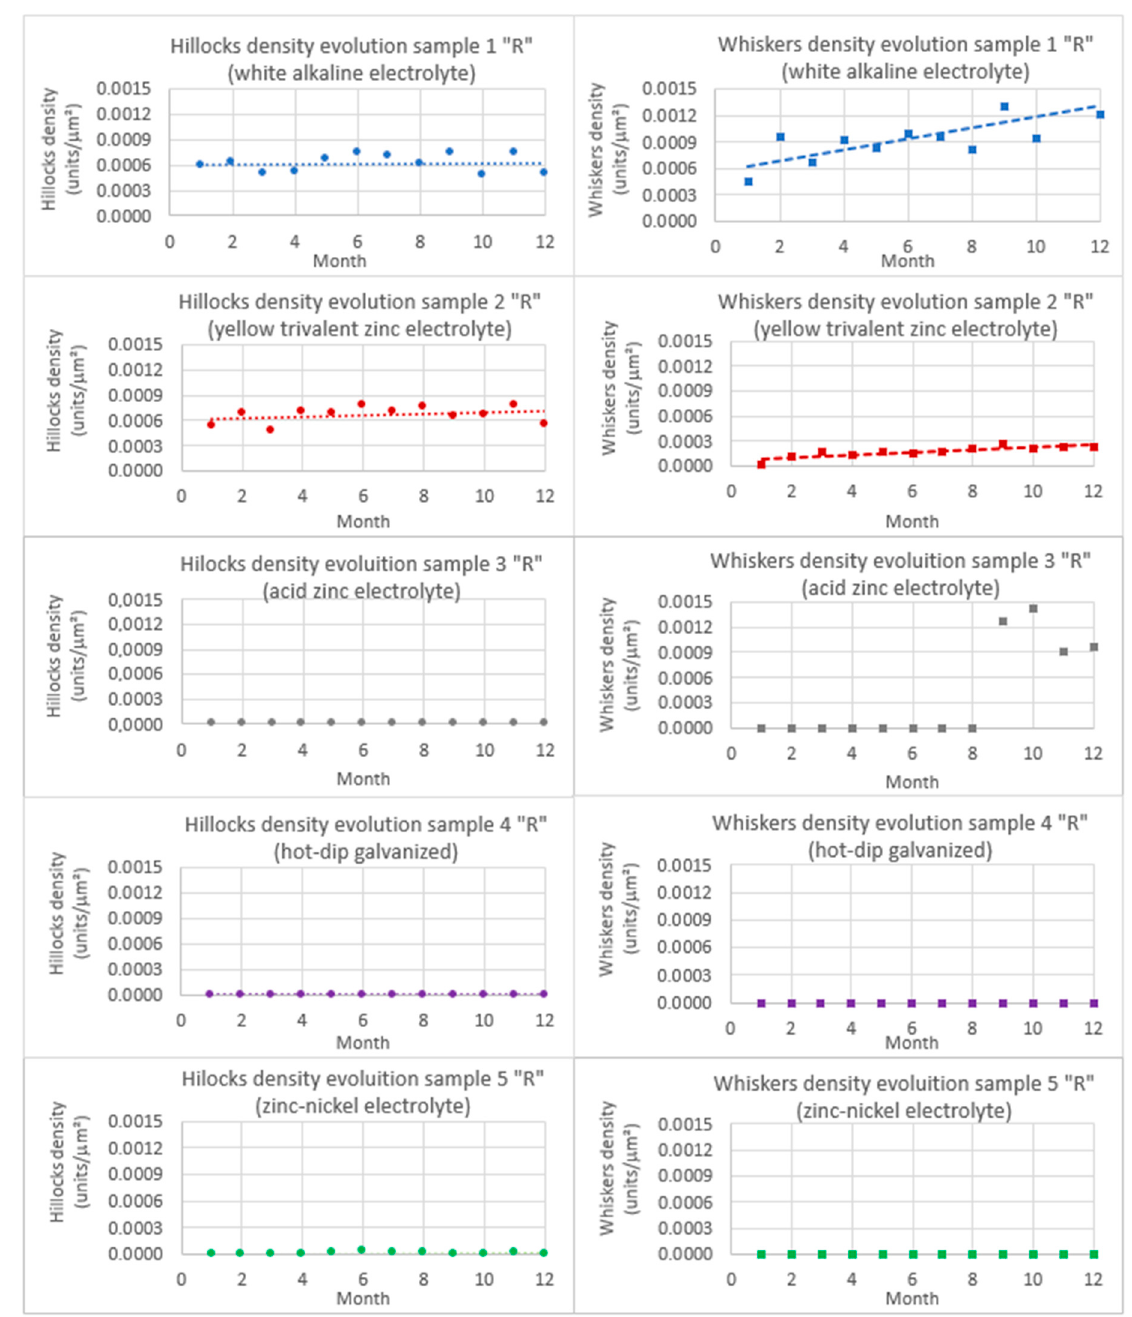
Figure 14. Evolution of hillocks and whiskers in as received “R” samples. If a comparison is made between samples 1 and 2 (white alkaline electrolyte coating and yellow trivalent zinc electrolyte coating, respectively), the hillock density is prac- tically constant and very similar, but the difference in the whisker density is relevant. Tests show that even at the beginning of the study it is possible to detect a one order of magnitude difference in the amount of whiskers, around 4.4 × 10 − 4 whiskers/ µ m 2 in white alkaline electrolyte (sample 1) and 2.4 × 10 − 5 whiskers/ µ m 2 in yellow alkaline (sample 2); in the 12th month, a 10-fold difference was observed, reaching densities of 1 × 10 − 3 whiskers/ µ m 2 and 2 × 10 − 4 whiskers/ µ m 2 for samples 1 and 2, respectively. As shown in the graphs, sample 3 (acid zinc electrolyte coating) did not show any hillocks or whisker progression over the first 8 months. However, traces of a beginning of growth